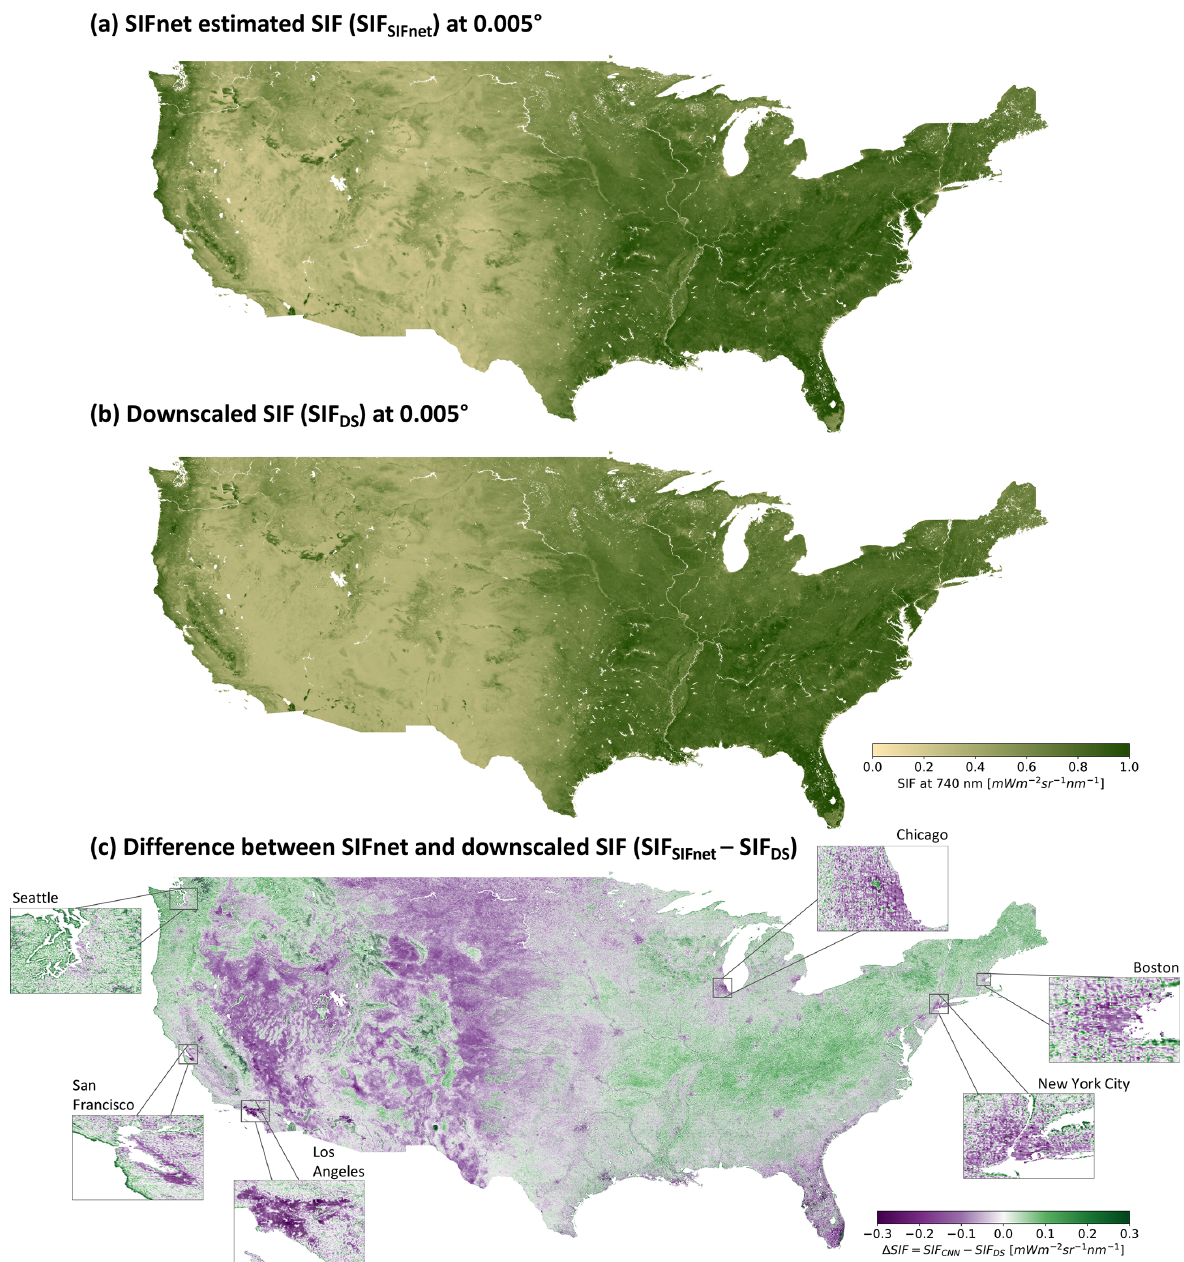
Figure 6. SIFnet estimated SIF at 0.005 ◦ for CONUS and its comparison to downscaled SIF. Panel (a) shows the SIFnet estimated SIF at 0.005 ◦ , (b) shows the downscaled SIF from Turner et al. (2020), and (c) shows the difference between SIFnet and downscaled SIF. Negative values imply a higher SIFnet SIF and positive values a higher downscaled SIF